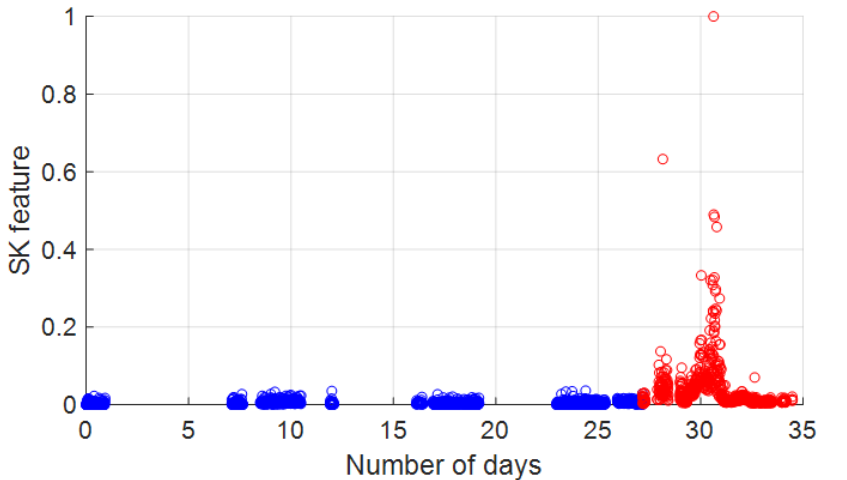
Figure 11. SK features vector after application of change detection